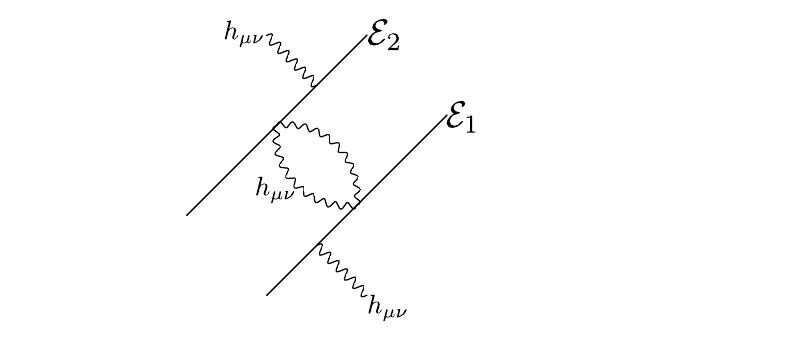
Figure 4 . A bulk picture of graviton production when passing through a shockwave. One can see that it is necessarily a loop e(cid:11)ect.